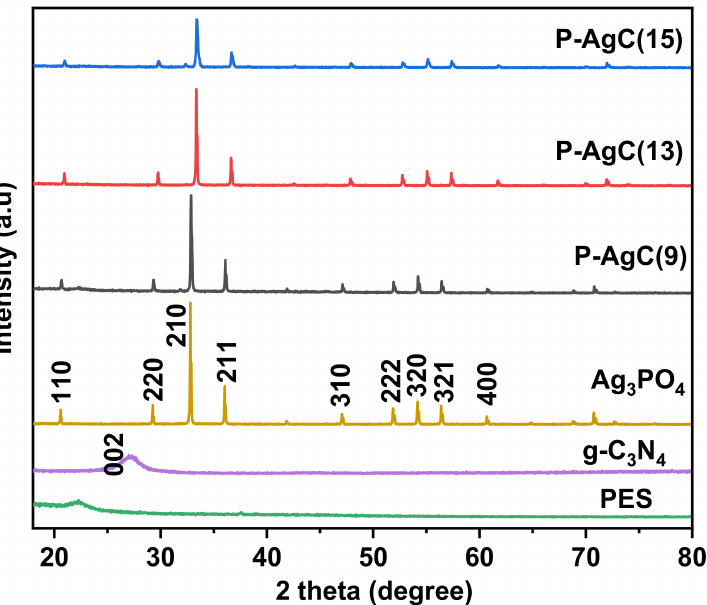
Figure 2. X-ray diffraction patterns of P-AgC in different loadings of Ag 3 PO 4 /g-C 3 N 4